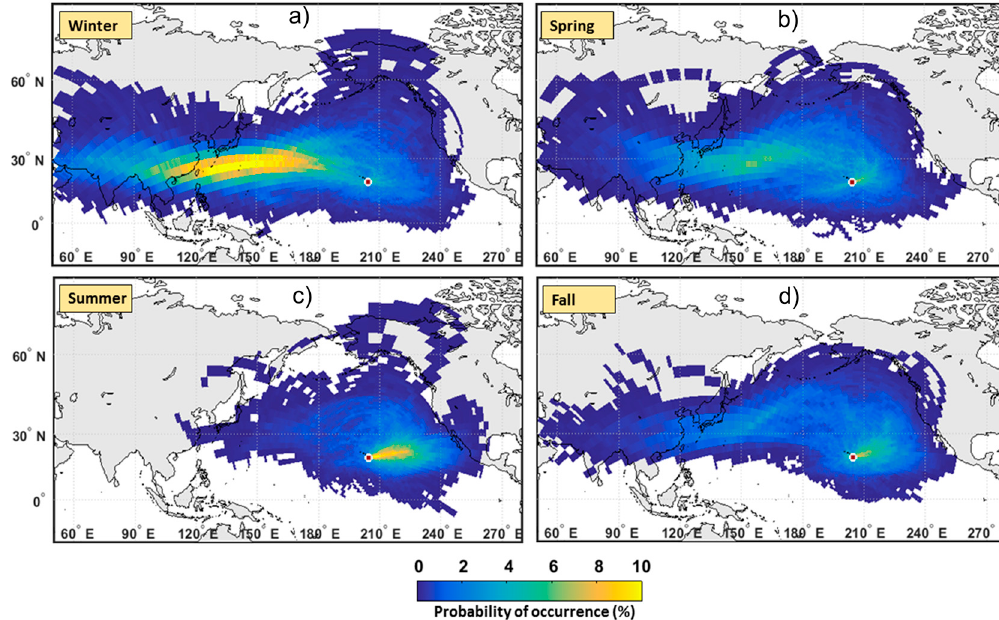
Figure 8. FLEXible TRAjectories (FLEXTRA) ECMWF 7-day back-trajectories starting at Mauna Loa (19.54° N, 155.58° W), Hawaii, at a height of 3000 m above sea level, subdivided with respect to ( a ) winter; ( b ) spring; ( c ) summer and ( d ) fall. Color shading denotes the probability of occurrence for air masses passing over a particular grid-cell before they arrived at Mauna Loa (see explanation in the text).